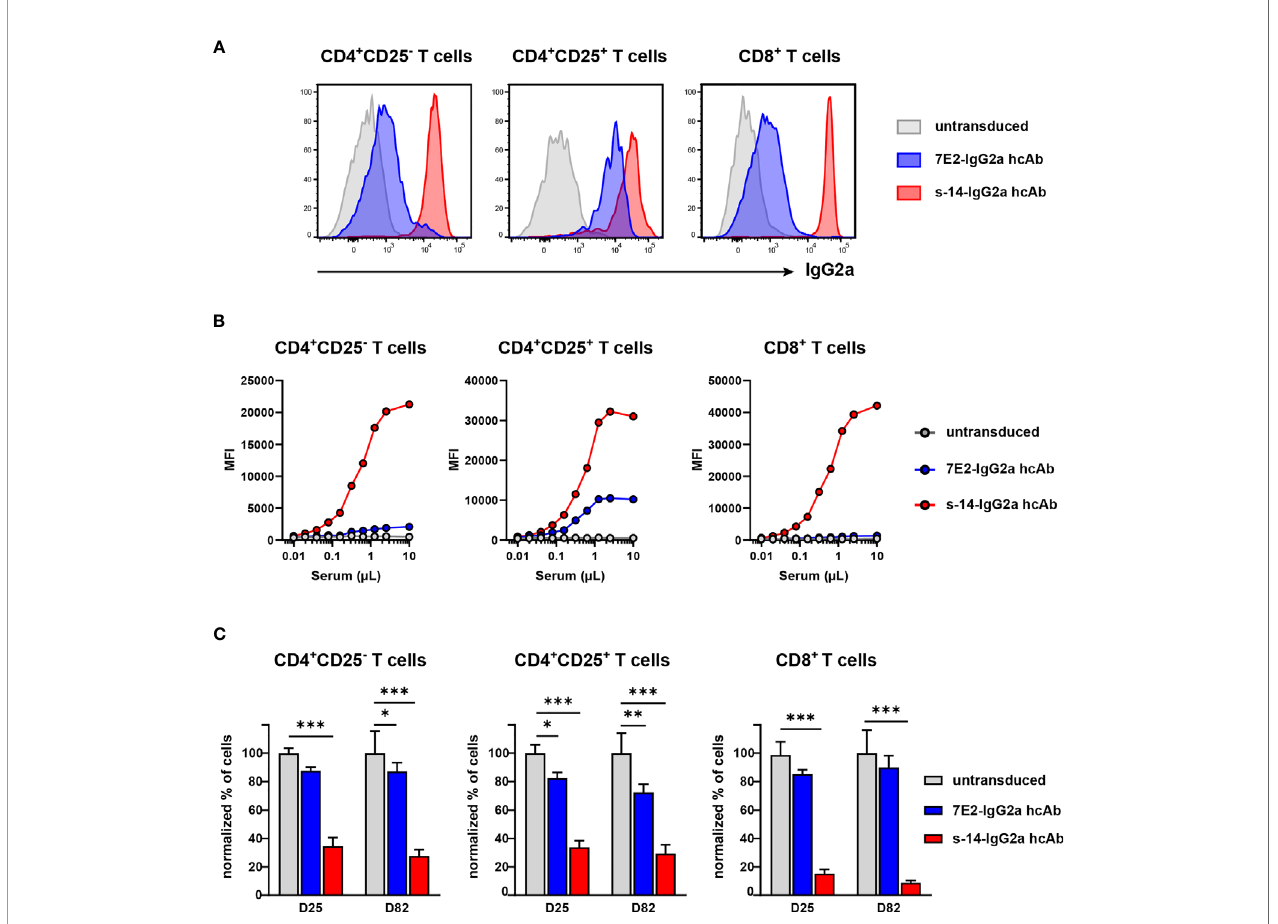
FIGURE 6 | AAVnano encoding nanobody-based IgG2a hcAb mediate depletion of cells expressing high levels of P2X7 or ARTC2.2. C57BL/6 mice were injected with PBS (untransduced, grey) or with rAAV8 encoding 7E2-IgG2a (blue) or s-14-IgG2a (red) hcAb. (A, B) Sera were collected 63 days post rAAV8 i.m. injection. To monitor the levels of hcAb in serum, splenocytes from an untreated naive C57BL/6 mouse were incubated with diluted serum, washed and bound hcAb were detected with an IgG2a-speci fi c secondary antibody. (A) Flow cytometry analyses illustrating the binding of each nanobody-based IgG2a hcAb on the indicated subset of splenic cells from an untreated mouse when using 10 m l of pooled sera collected from rAAV injected mice. (B) Splenocytes from an untreated mouse were incubated with serial dilutions of sera to titrate the relative abundance of the two hcAb. For both hcAb, serum volumes between 1-10 µL were enough to saturate the signal. (C) To evaluate depletion of T cell subsets in vivo , blood samples were collected 25 days and 82 days after i.m. injection of rAAV encoding the indicated IgG2a hcAb. Cells were stained with fl uorochrome-conjugated antibodies and analyzed by fl ow cytometry. Normalized percentage of CD4 + CD25 - , CD4 + CD25 + and CD8 + T cells are shown, as compared to the percentages of cells found in the control group taken as 100%. Staining was performed using fl uorochrome conjugated antibodies speci fi c to CD45 (coupled to PerCP-Cy5.5), CD4 (APC-Cy7), CD8 (PE-Cy7), CD25 (PE) and biotinylated antibody to mouse IgGa and streptavidin-APC. Errors bars represent the SEM and statistical analyses were performed using one-way ANOVA (n=7 in each group, *p < 0.05, **p < 0.01, ***p <